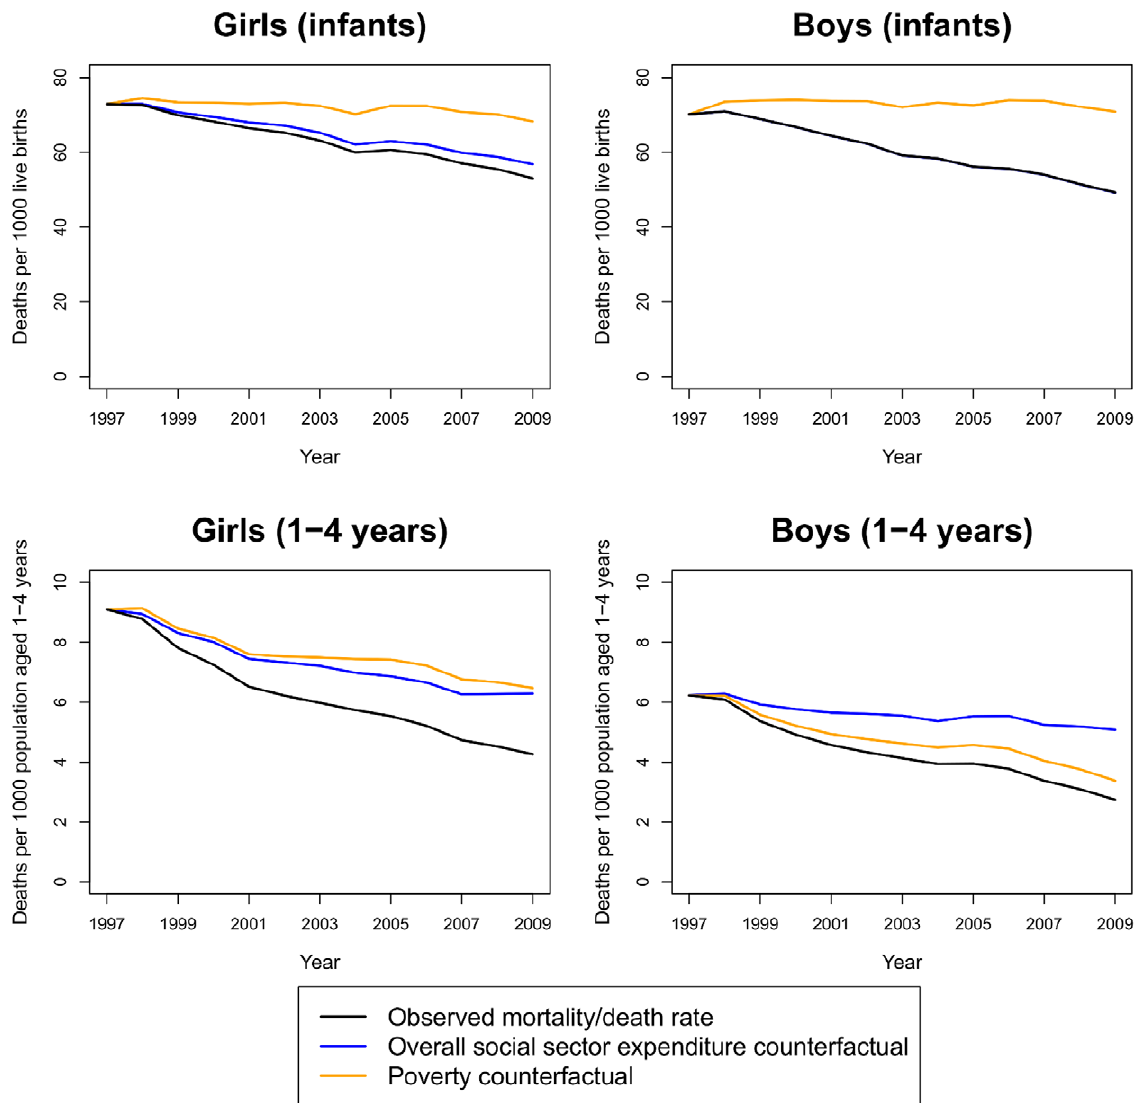
Figure 3. Observed and counterfactual mortality trends among infants and children aged 1–4 years, 1997–2009. The observed mortality rate (for infants) or death rate (for age 1–4) is shown in black; the overall social sector expenditure counterfactual shows the predicted mortality/death rates if state per-capita overall social sector expenditure had remained at its 1997 level (blue); the poverty counterfactual shows the predicted mortality/death rates if poverty rates had remained at their 1997 levels (orange). (Note: the effect of overall social sector expenditure on mortality is essentially zero in boys less than one. Hence, the mortality rate under the overall social sector expenditure counterfactual [blue] coincides with the estimated mortality rate